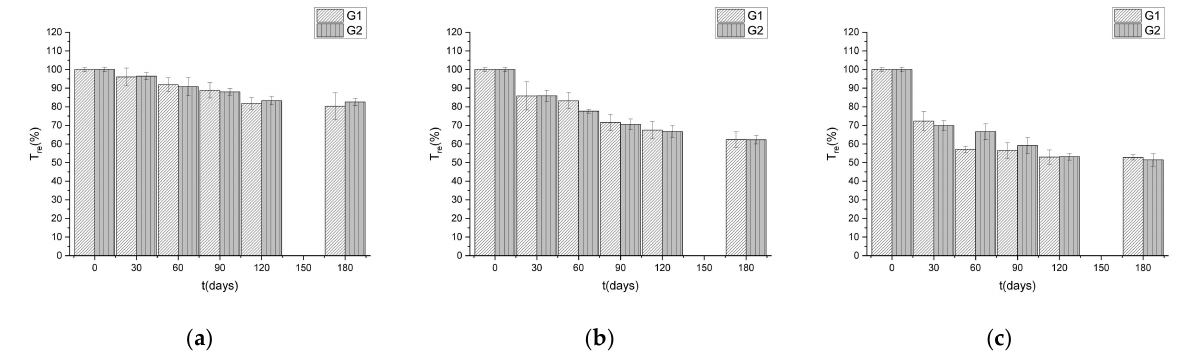
Figure 8. Tensile strength retention of two types of GFRP bars after accelerated aging at different ages: ( a ) 20 °C; ( b ) 40 °C; ( c ) 60 °C. Table 1. Comparison of residual tensile strength between this article and Wu [32]. Time (Days)